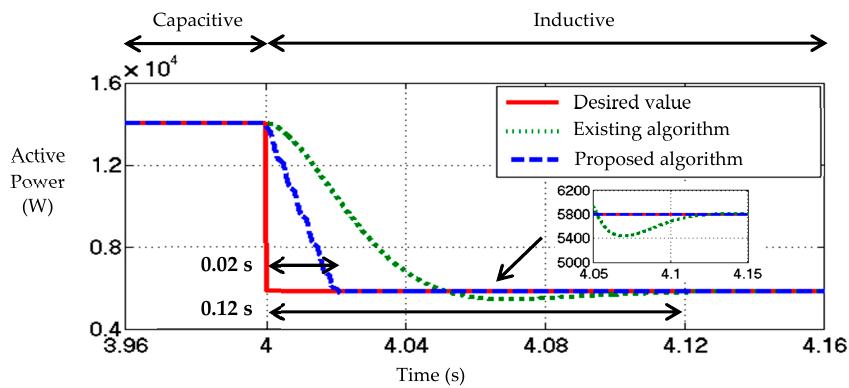
Figure 6. Fundamental element of active power p ( dc ) detected by each reference current generation algorithm, for dynamic-state condition of capacitive to inductive loads.